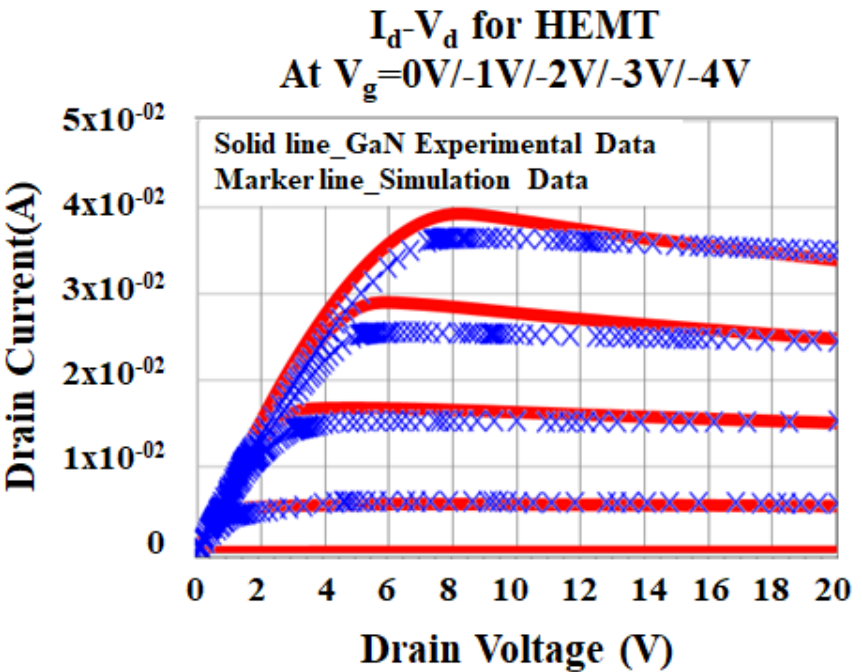
Figure 10. I d − V d characteristics of the simulated data and GaN wafer experimental data.